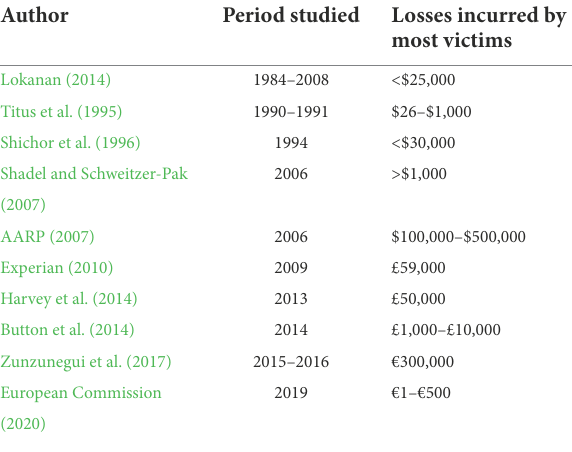
TABLE 6 Losses incurred by victims across